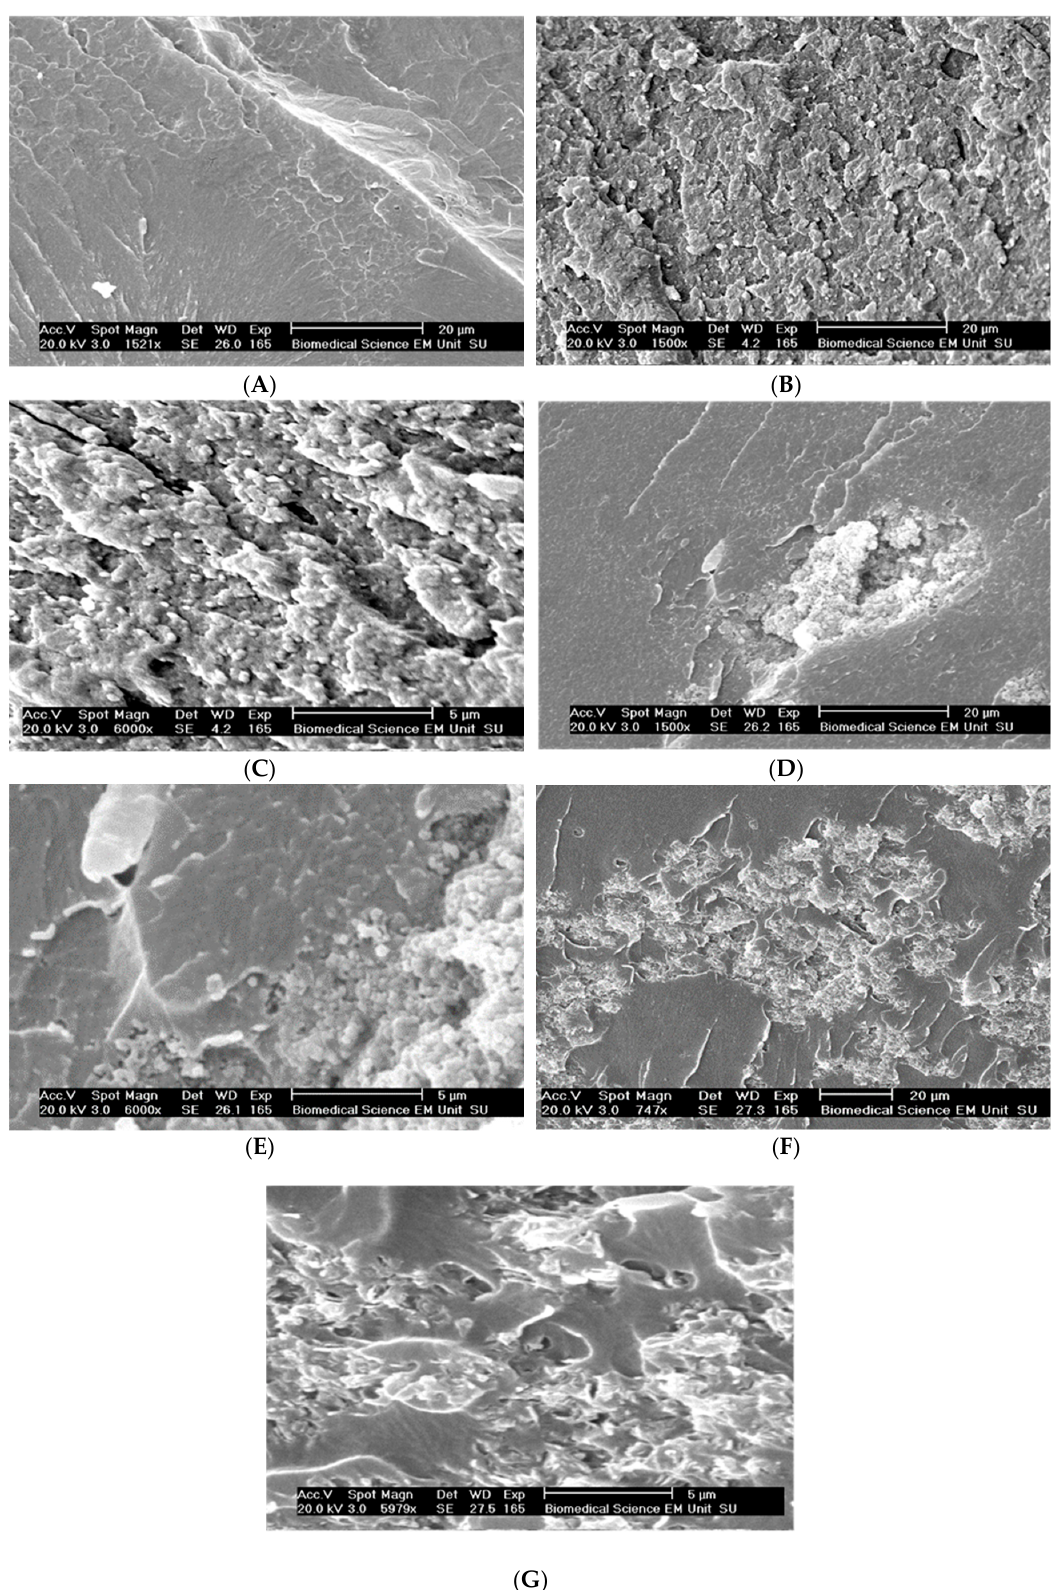
Figure 15. SEM images of fractured surfaces of the resins. ( A ) Plain resin. ( B ) Silanated silica-resin (2 w %). ( C ) Silanated silica-resin (2 w %). ( D ) Silanated TiO 2 -resin (1 w %). ( E ) Silanated TiO 2 -resin (1 w %). ( F ) Silanated nanoclay-resin composites. ( G ) Silanated nanoclay-resin composites.